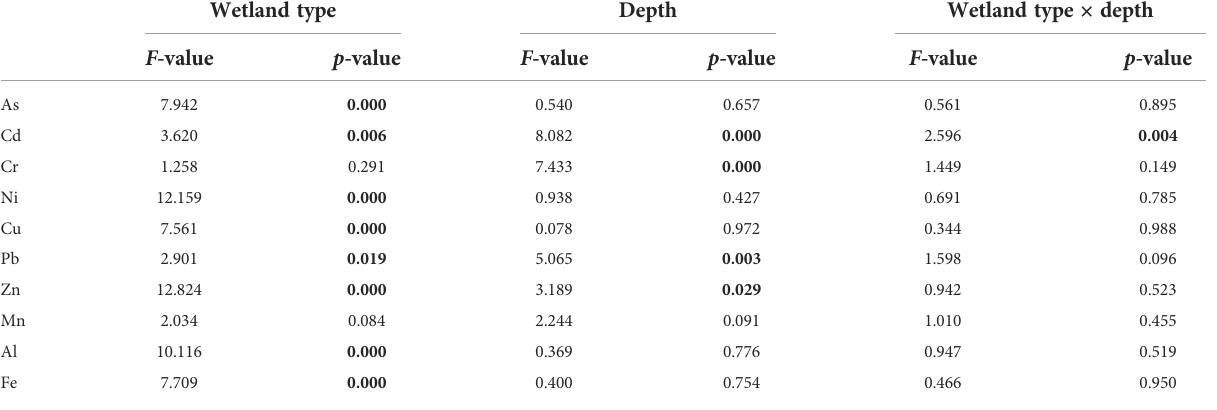
TABLE 2 Difference test results of the general linear model